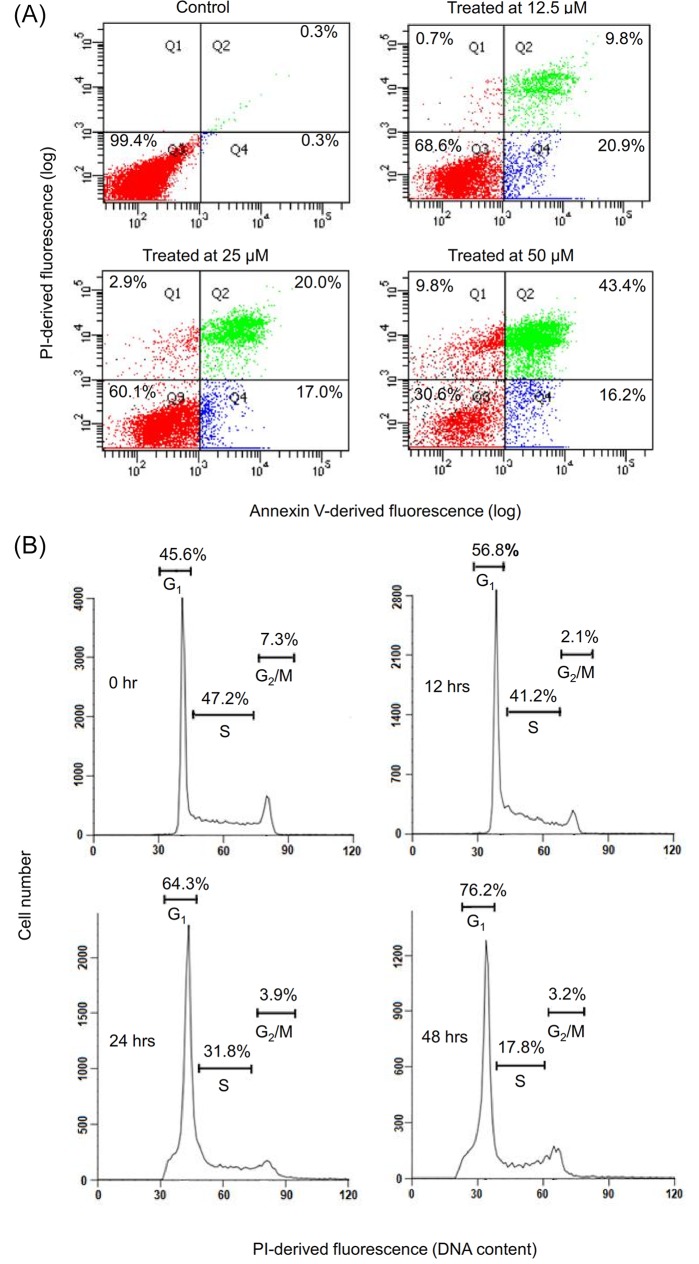
Effect of the cycloartane on HT-29 cell death (apoptosis and necrosis) and cell cycle progression.(A) Percentage of cells showing phosphatidylserine translocation, as measured by cell-surface annexin V binding and free PI: cells negative for annexin V and positive for PI are necrotic (Q1); cells positive for both annexin V and PI are in late apoptosis (Q2); cells negative for both annexin V and PI (Q3) are viable cells; and cells positive for annexin V and negative for PI are in early apoptosis (Q4). Cells were incubated for 24 hours with 0.1% v/v DMSO4 (vehicle control) or the cycloartane at concentrations of 12.5, 25, or 50 μM, as indicated. (B) Flow cytometry histograms showing the distribution of cells in different phases of the cell cycle (G1, S and G2/M) at the beginning of the experiment (0 hr) and at 12, 24 and 48 hours of treatment with 2.5 μM of the cycloartane. The result is representative of one of three replicates that had essentially similar results.